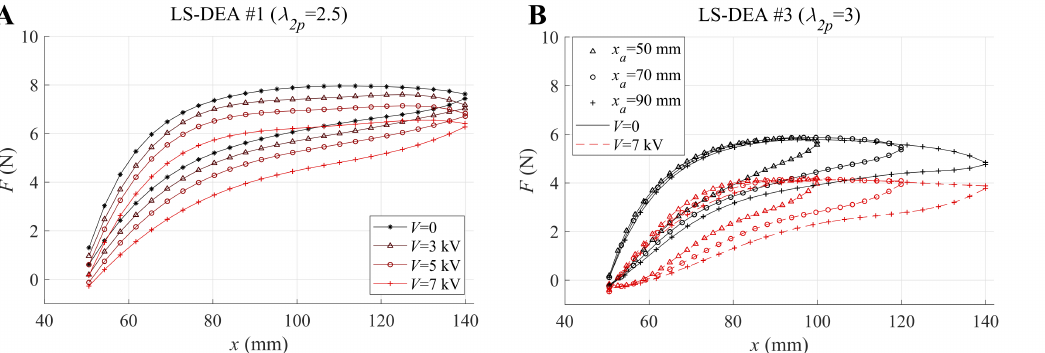
Figure 5. ( A ) Stabilized force-displacement curves for LS-DEA #1 subject to cyclic displacements ( ∆ x = 90 mm) at different voltages. ( B ) Stabilized force-displacement curves for LS-DEA #3 subject to cyclic displacements with different amplitudes: solid lines refer to tests in the absence of applied voltage, while dashed lines refer to tests with voltage V = 7